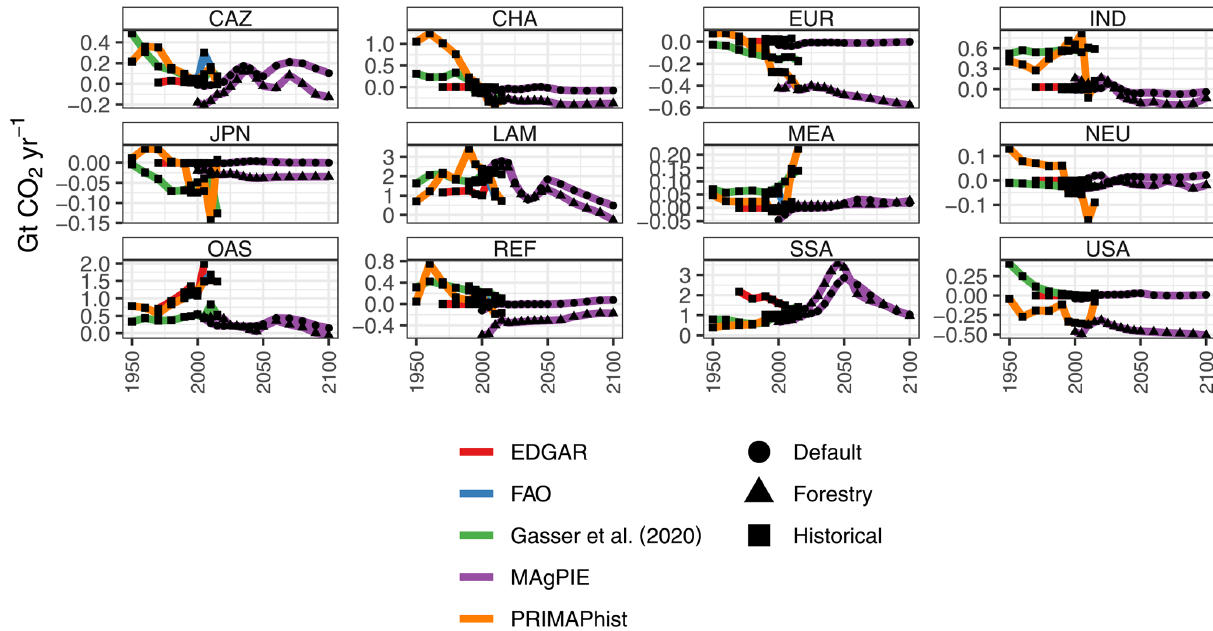
Figure A6. Regional annual net land-use change emissions (in GtCO 2 yr − 1 ;